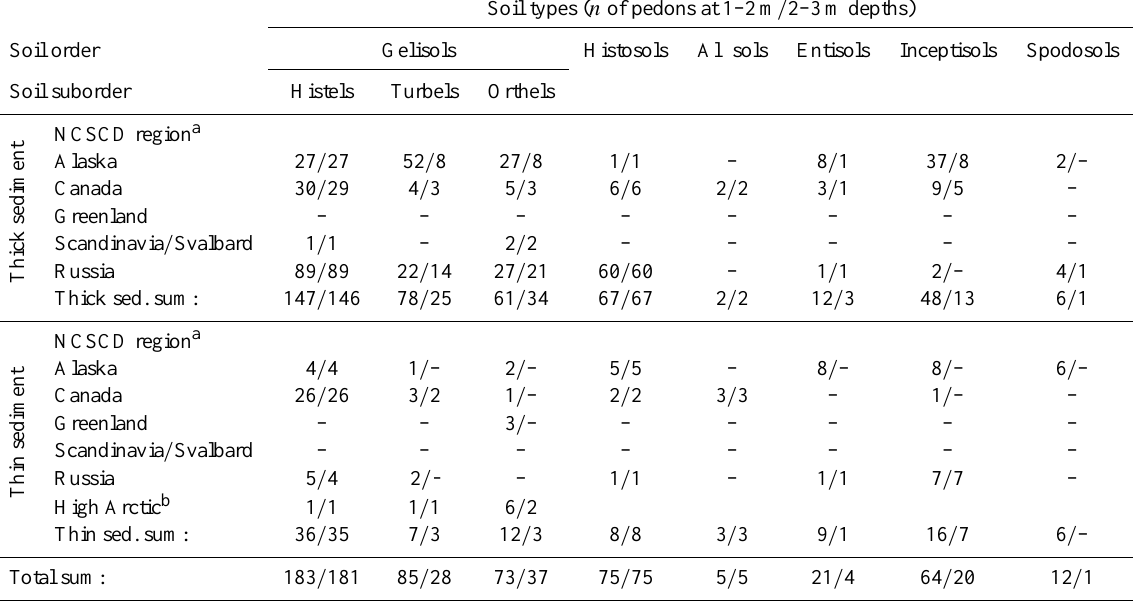
Table 1. Summary of number of available pedons (with data below 1m) in areas with thick and thin sedimentary overburden for soil taxa from different regions (regional subdivision following NCSCD database structure) in the northern circumpolar